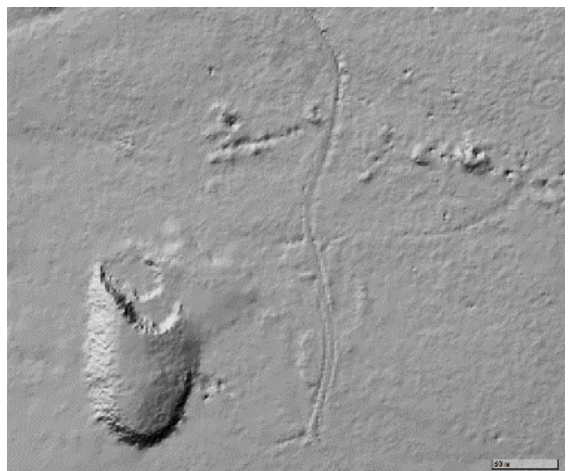
Figure 1. The DRM of Eastern part of Abertamy mining region; ALS, Czech Geodetic and Cadastral Office. The historical remnants are quite visible (in the upper part of the image), such as the nearby big deposit from Uranium mining (bottom left the big